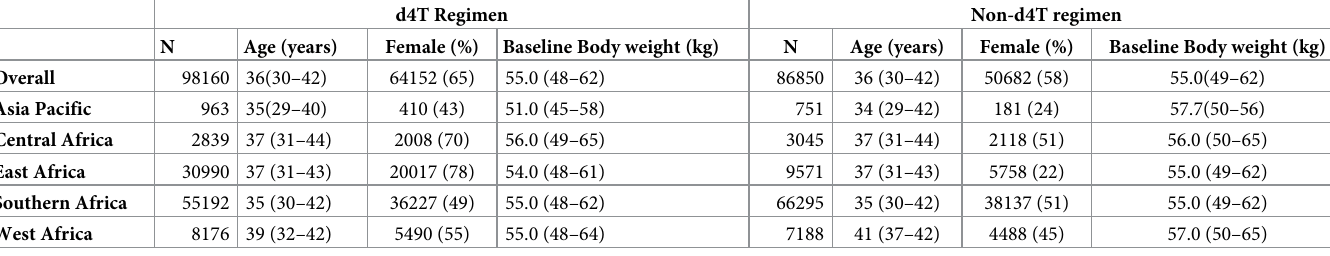
Table 2. Summary of baseline characteristics-IeDEA study by d4T and non-d4T based regimen. d4T Regimen Non-d4T